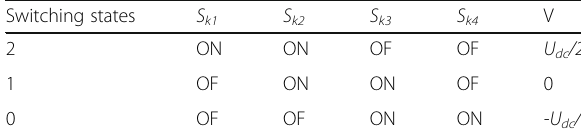
Table 2 Switching states of the three-level